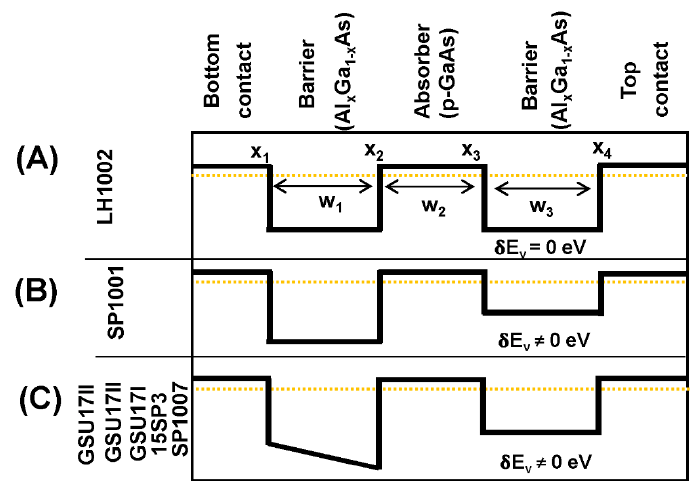
Figure 6. Schematic diagrams of the valence band alignment of the detector designs under equilibrium. ( A ) Detectors without barrier offset LH1002. ( B ) SP1001 consists of an emitter at the bottom, the barrier at the top, with an energy offset ( δ E v) of ~0.10 eV between the barriers. ( C ) In SP1007, 15SP3, GSU17I, GSU17II, and GSU17III have graded bottom by tuning the Al mole fraction and barrier offset δ Ev not equal to zero. Table 1. Summary of results from the temperature-dependent internal photoemission spectroscopy (TDIPS) fitting method with corresponding device parameters (threshold wavelength is also shown).